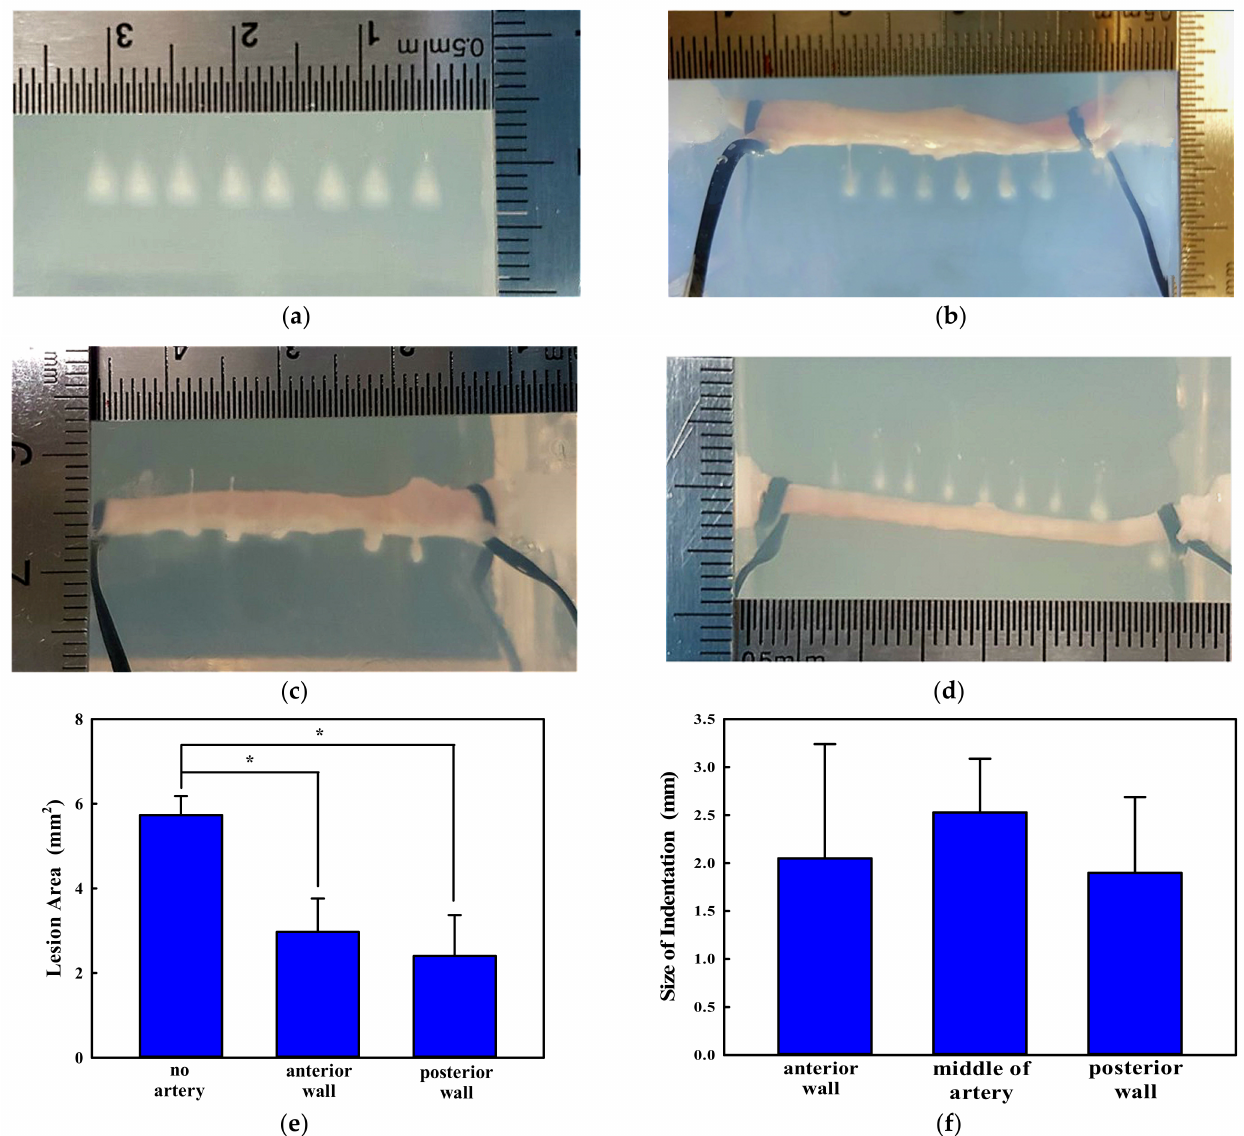
Figure 3. Representative images of HIFU-induced lesion: ( a ) without the inclusion of an artery in the gel phantom, compared to the HIFU focus aligned to ( b ) the anterior artery wall, ( c ) middle of the artery, and ( d ) the posterior artery wall. Comparison of ( e ) HIFU-induced lesion area in the polyacrylamide gel phantom without the inclusion of the artery, HIFU focus aligned to the anterior and posterior artery wall, and ( f ) the size of indentation on the artery wall with the HIFU focus aligned to the anterior wall, middle of the artery, and the posterior wall, *: p >